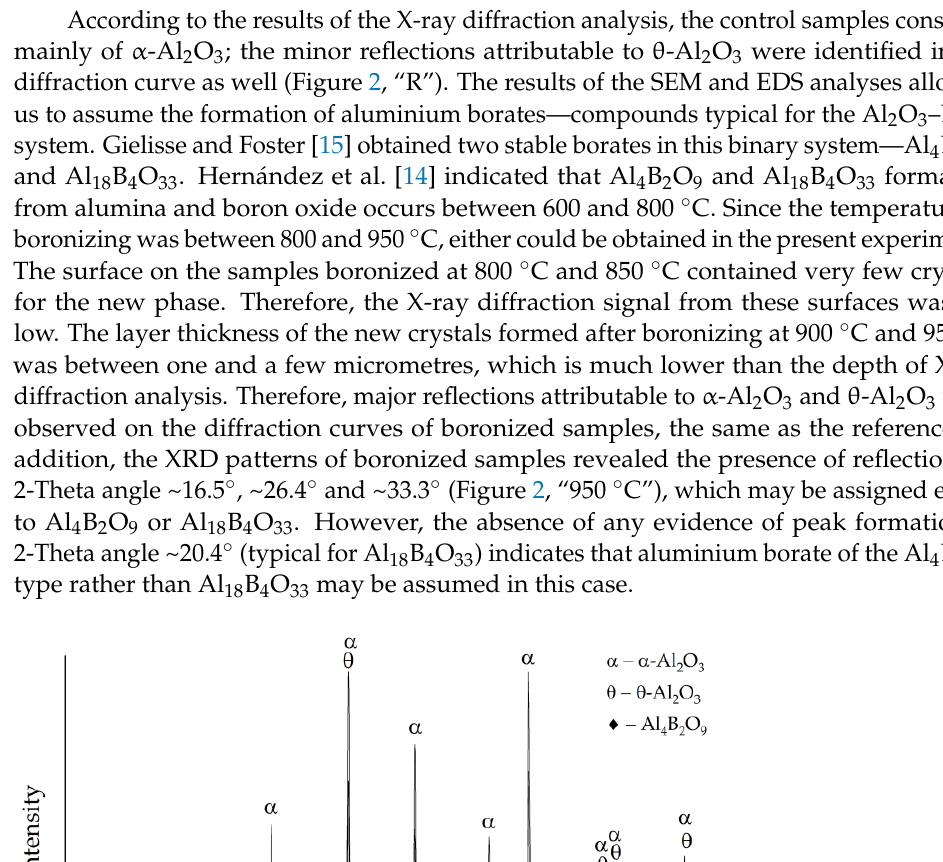
Figure 1. SEM micrographs of the reference Al 2 O 3 sample surface ( a ) and surfaces of Al 2 O 3 samples after boroniz ing at 800 °C ( b – d ), 850°C ( e , f ), 900°C ( g – i ) and 950 °C ( j – l ) temperatures; ( b ) yellow ovals show points of the appearance of aluminium borate crystals on surface; in images, the concen-